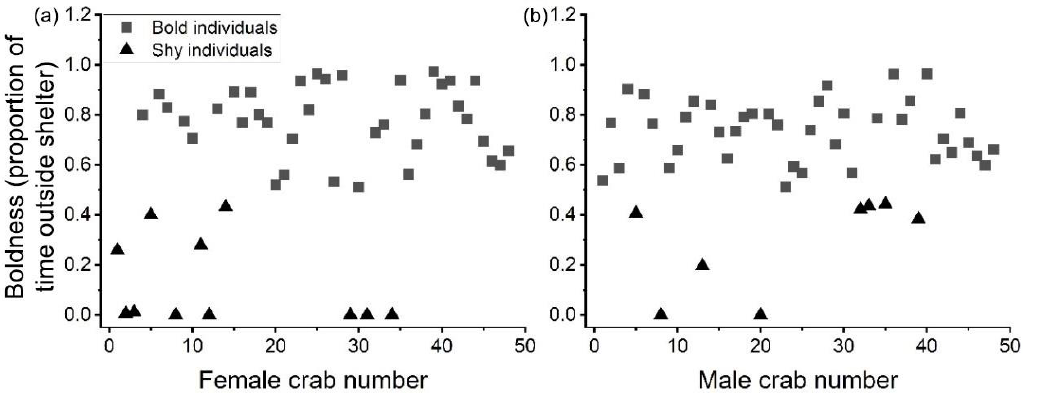
Figure 2. The result of PAML according to the boldness of female swimming crab ( a ) and male swimming crab ( b ).